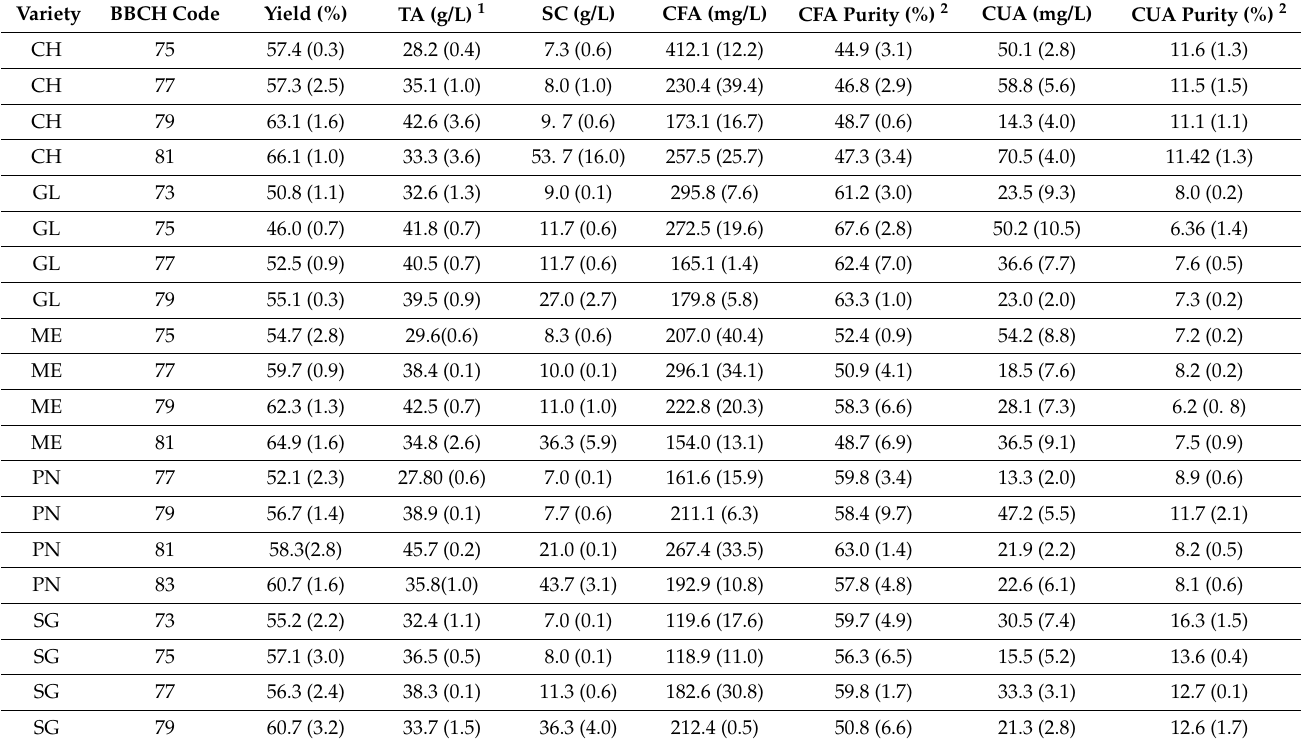
Table 1. Yield, titratable acidity (TA), sugar content (SC), caftaric (CFA), and coutaric acid (CUA) concentration of verjuice obtained by different grape varieties during green berries maturation. Values represent the mean averages (n = 3) and standard deviation (in